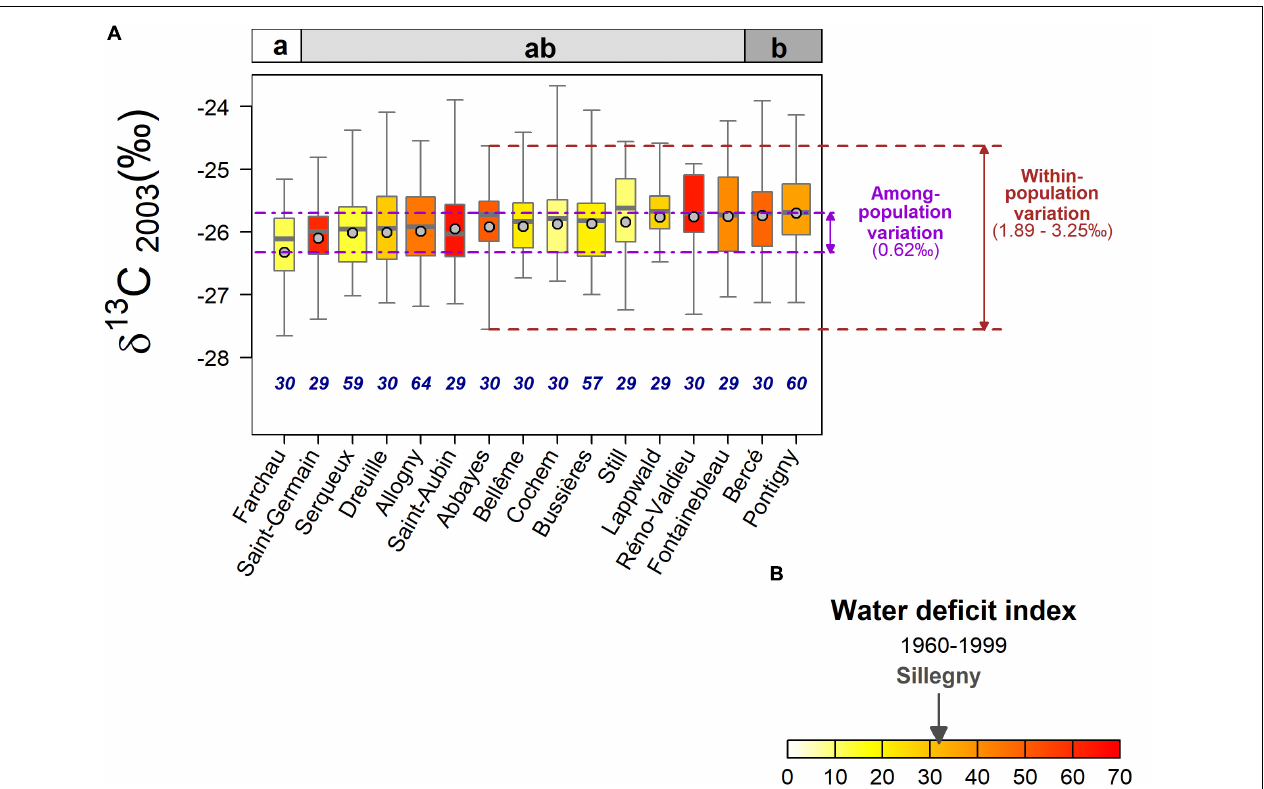
). Populations are ordered from the left to the right by increasing least-square FIGURE 3 | (A) Within- and among-population variations of the 2003 tree ring δ 13 C ( mean values of δ 13 C (gray circles). The bottom and the top of the box are the first and the third quartile, respectively, and the bold line represents the median. The (cid:104) whiskers are extending from minimum to maximum values for each population. The box colors indicate the average water deficit index (dimensionless) calculated over the 1960–1999 period (B) (see Figure 1 and Supplementary Table 1 ). Different letters in the upper panel indicate significant differences among populations. For each population, the box width is proportional to the sample size (n), which is also displayed below each corresponding box.